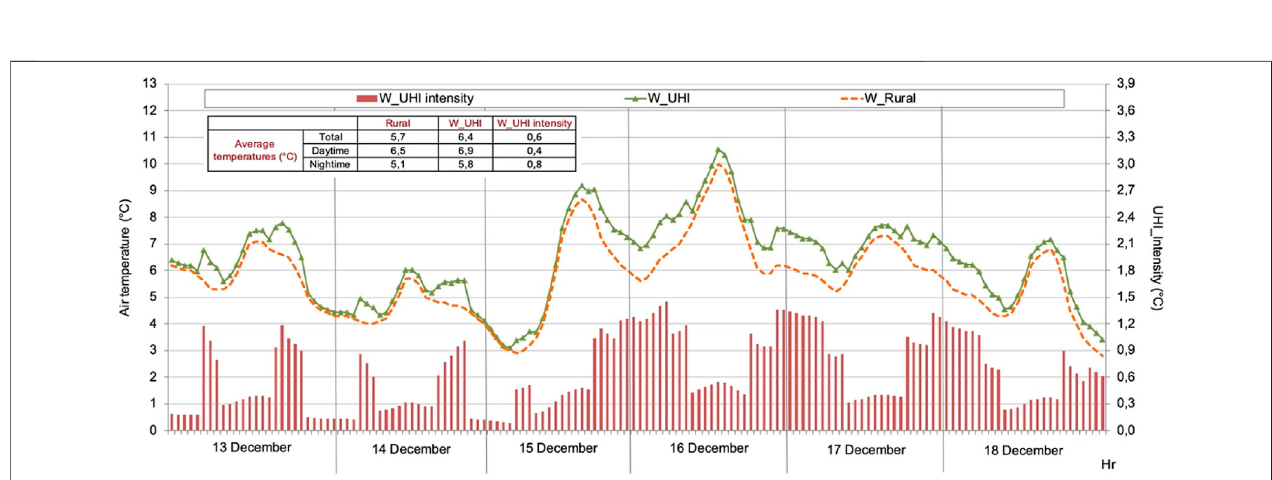
FIGURE 7 | Outdoor temperatures of rural and urban weather in case UHI_1 or UHI_2 on 6 days in July and corresponding UHI intensities. Their average values in the three daily periods are also shown.